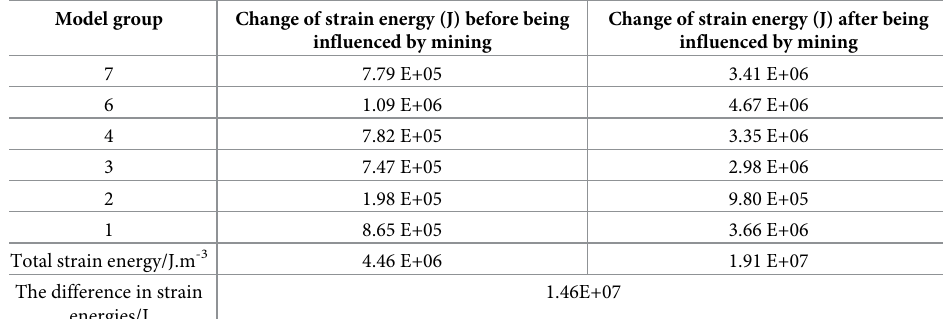
Table 6. Changes in strain energy density as influenced by mining-induced stress under simulated conditions.